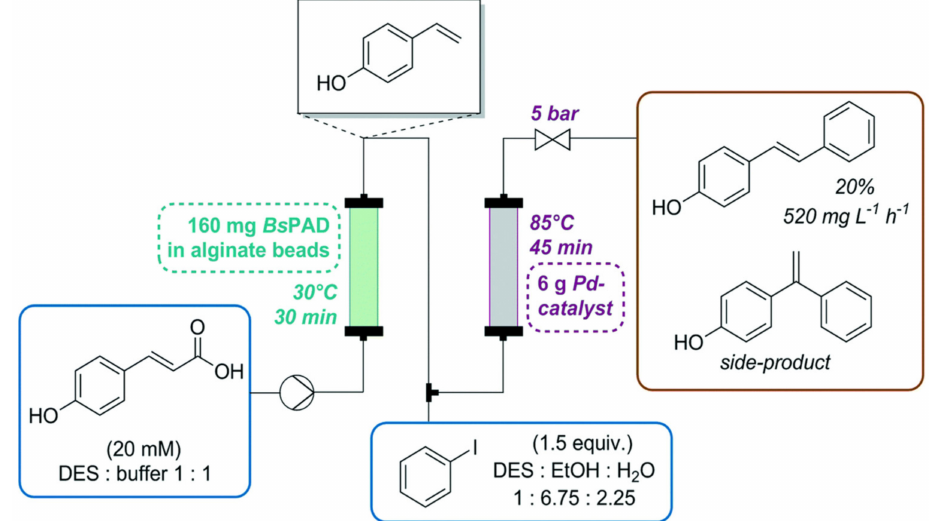
Figure 12. General scheme for asymmetric chemoenzymatic synthesis of stilbenes [68]. Published by The Royal Society of